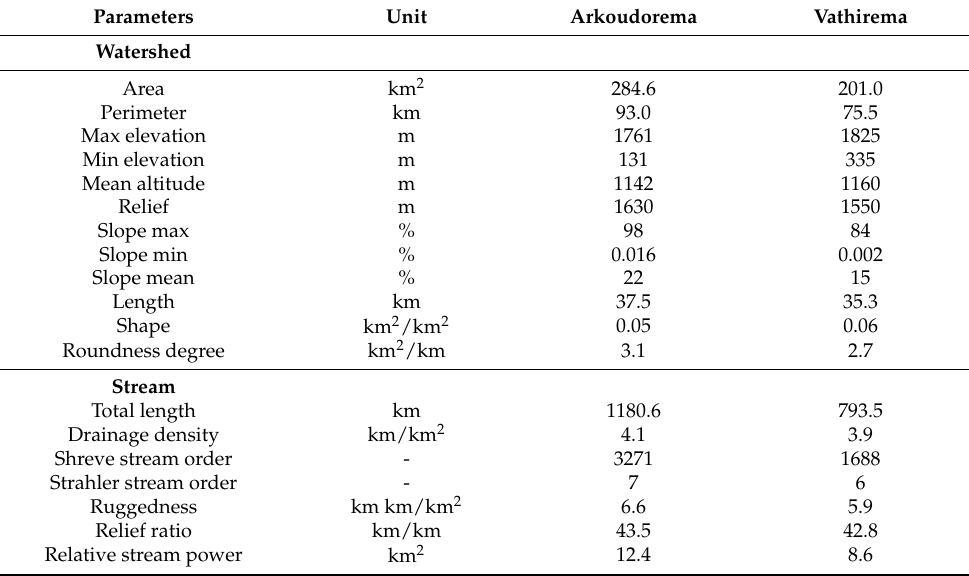
Table 2. The fluvio-geomorphometric parameters derived for each of the studied sub-watersheds.